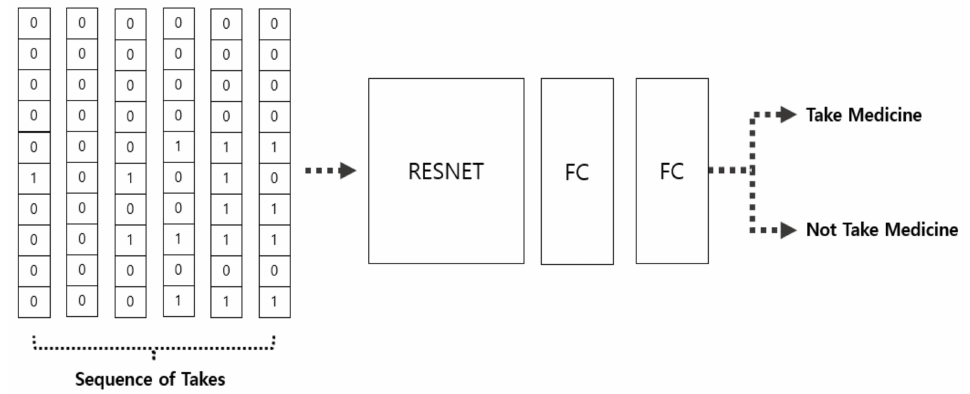
Figure 8. CNN classification model for medication behavior recognition .